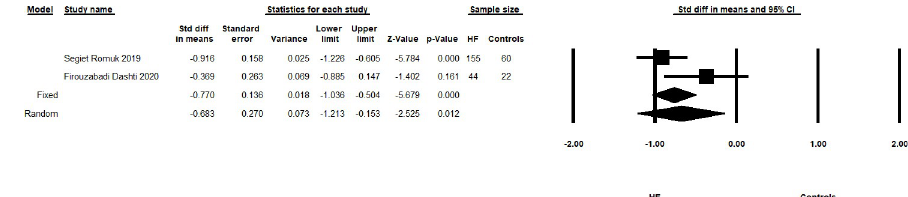
Fig 2. Summary forest plots showing the Meta-SMD and 95% CI of IL-33 levels in HF patients and healthy controls. The Meta-SMD in the random effects model is shown by the black diamond at the bottom. The vertical line at 0.00 is the border for significance.